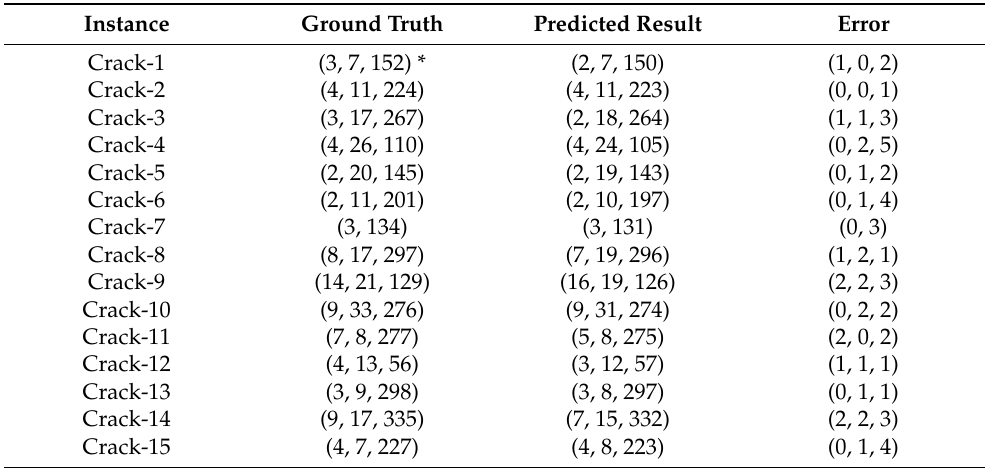
Figure 14. Crack quantification results of the proposed algorithm: ( a – h ) represents different crack instances. Table 4. Comparison of ground truth and the results of the proposed